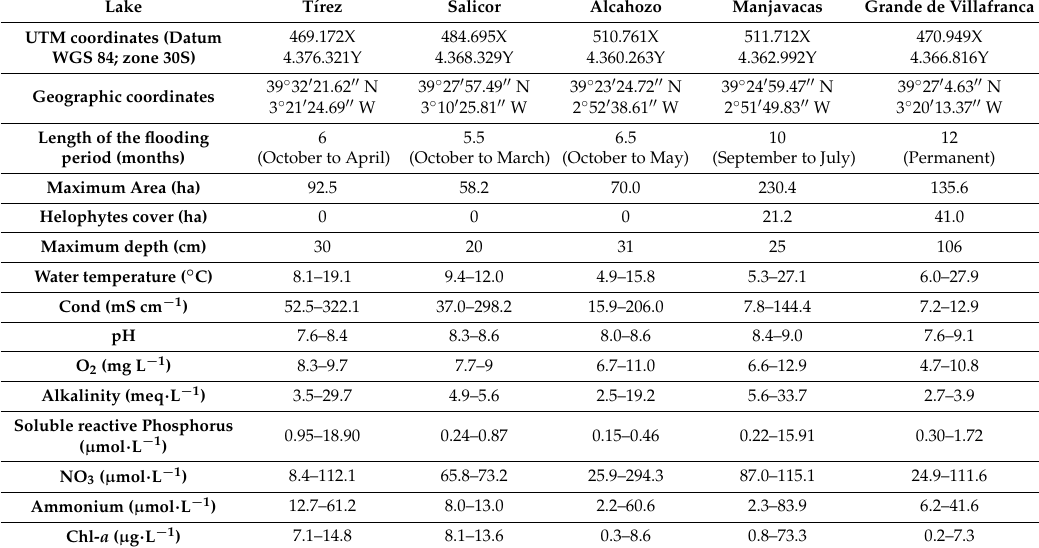
Table 1. Location, environmental characteristics and range of main environmental variables in the studied lakes during the sampling period. Water variables correspond to the flooding period. Lakes are sorted from left to right according to their salinity (see Cond–water electrical conductivity). T í rez Salicor